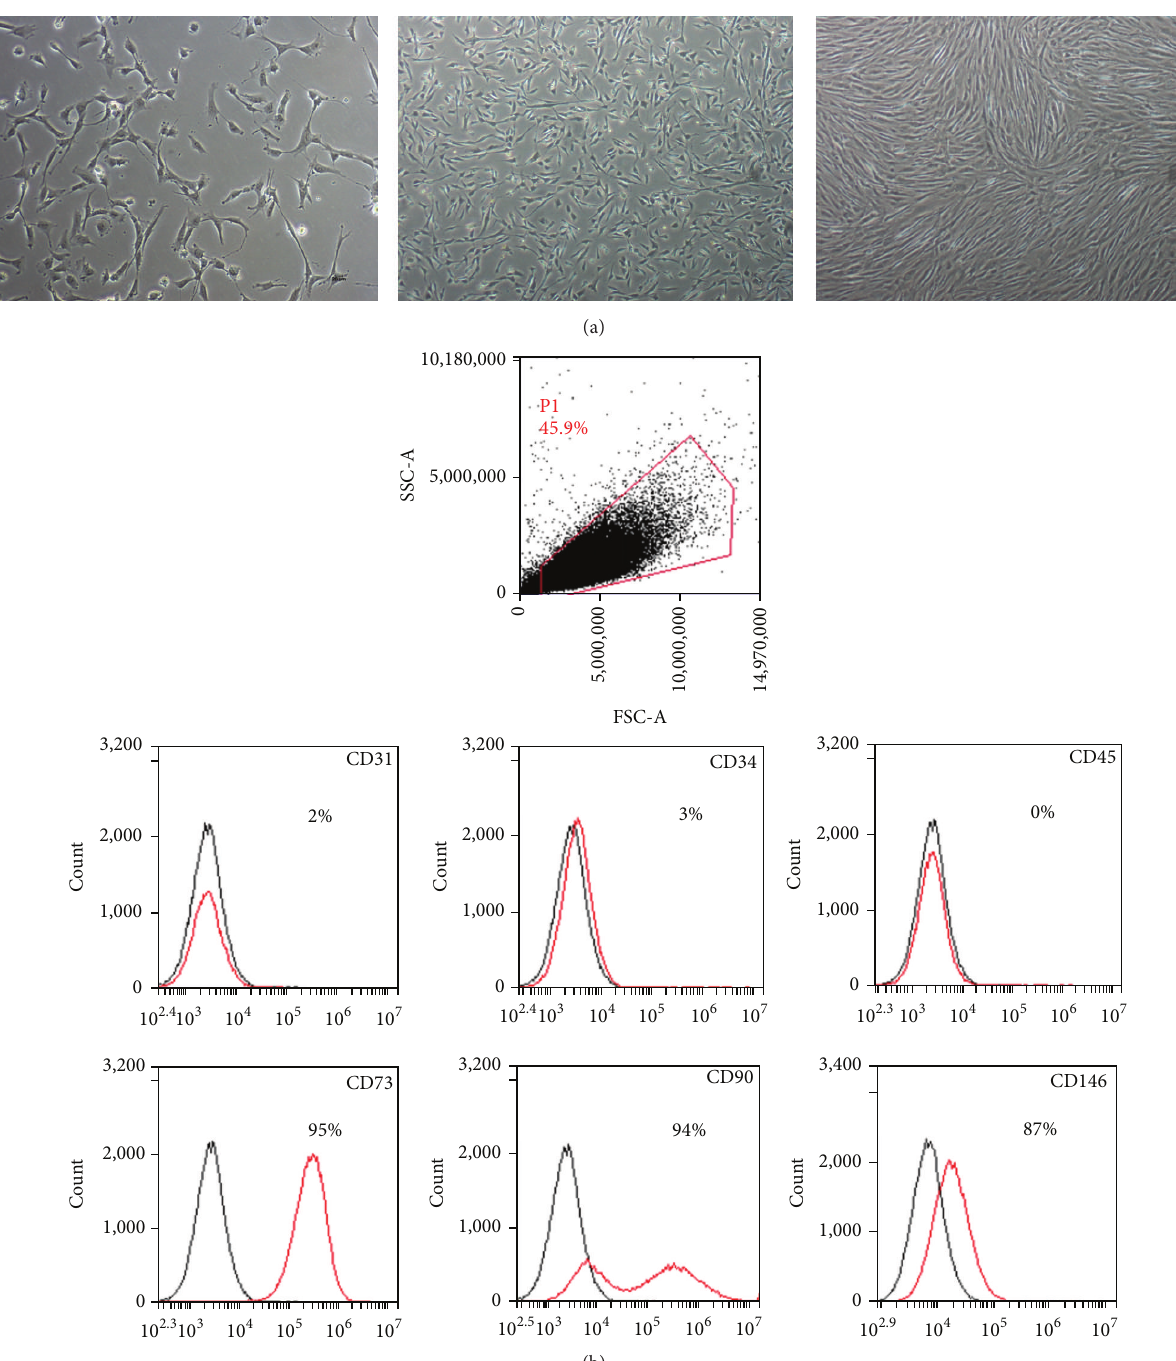
Figure 1: FL-MSC characterization. (a) Morphology of primary layers of adherent MSCs isolated from human fetal liver at low, medium, and high confluence. Magnification: 100x. (b) Cell surface markers expression profile in FL-MSCs. CD31, CD34, CD45, CD73, CD90, and CD146 markers were analyzed using flow cytometry. Immunopositive expression is shown as histograms (red) and compared to corresponding control isotypes IgG (black). The flow cytometry histograms are representative of at least three cell populations isolated from different